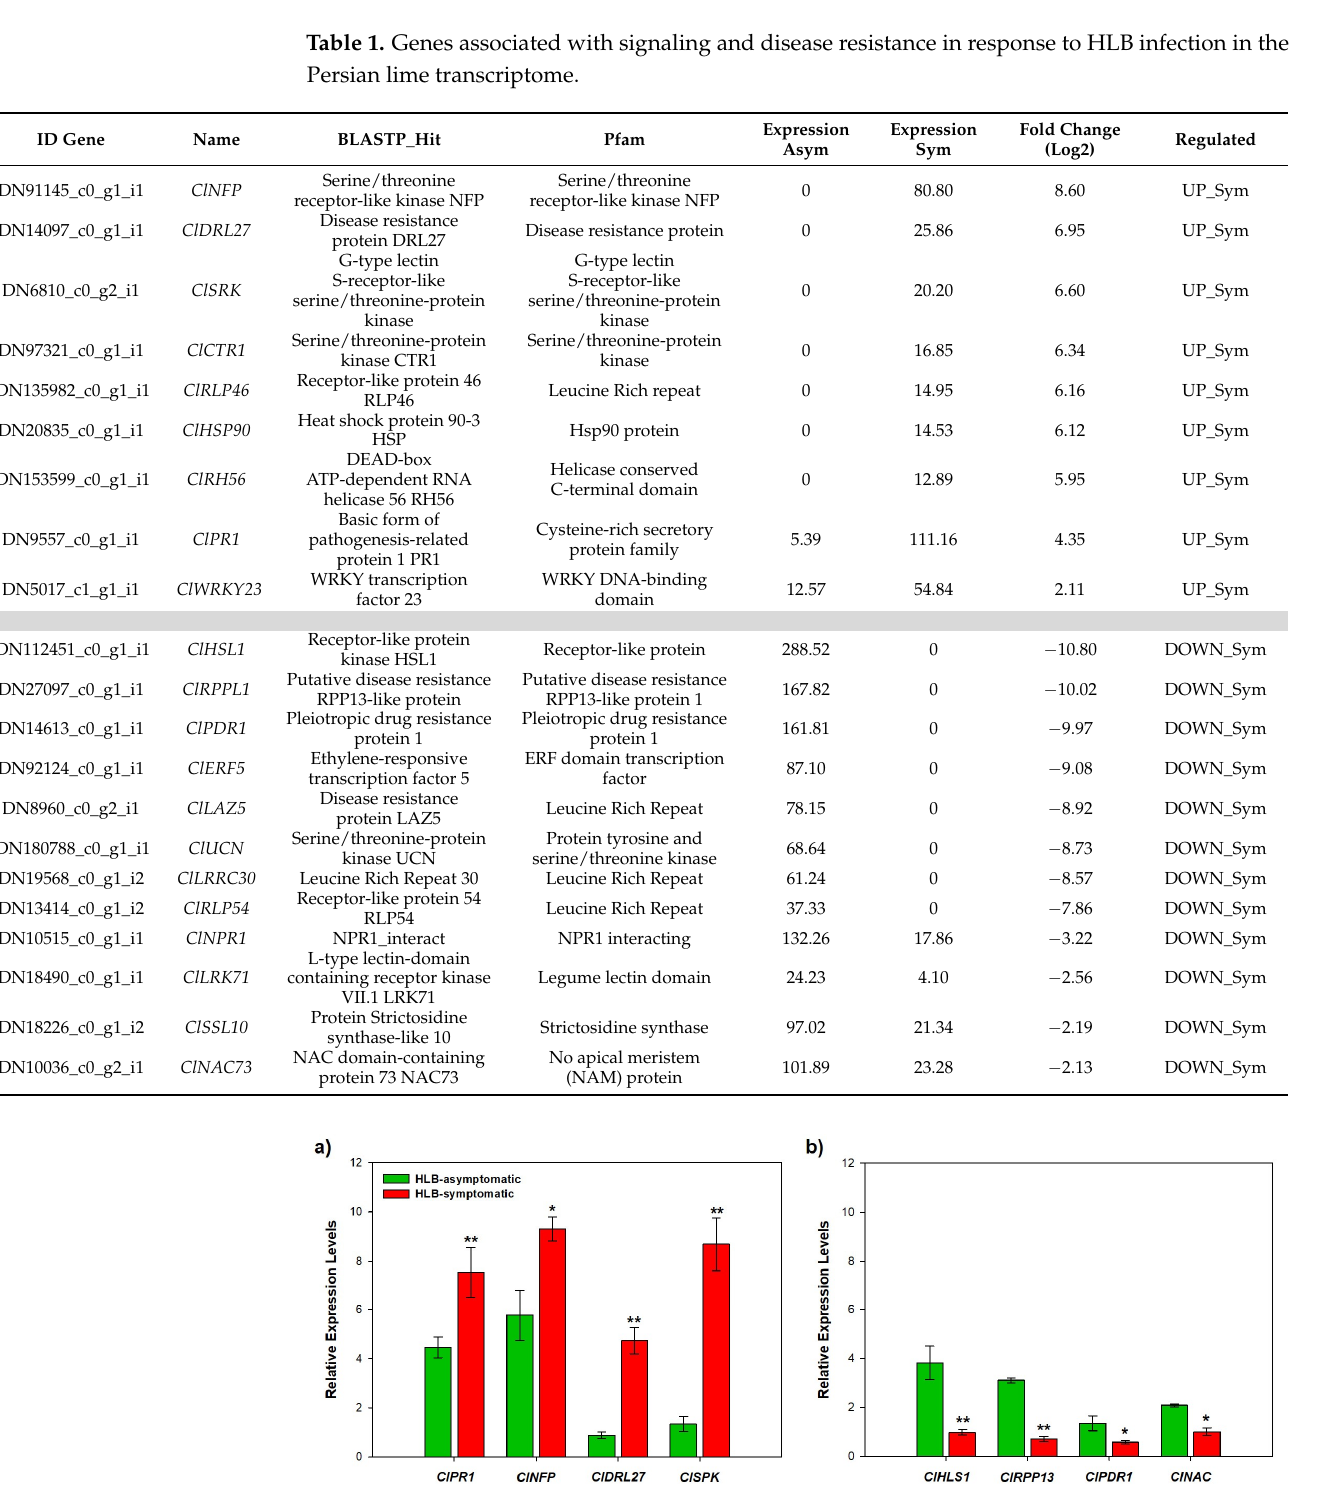
Figure 6. RT-qPCR validation of eight DEGs from the HLB diseased Persian lime transcriptome. Four upregulated ( a ) and four downregulated ( b ) DEGs by C Las infection in the transcriptome show similar Relative Expression Levels in C Las-infected (red bars) and healthy (green bars) Persian lime leaves. mRNA abundance was normalized using the housekeeping UPL7 gene. Vertical bars represent the mean ± SD ( n = 3 for each group). Significant differences from controls are expressed as ** p < 0.01, * p <